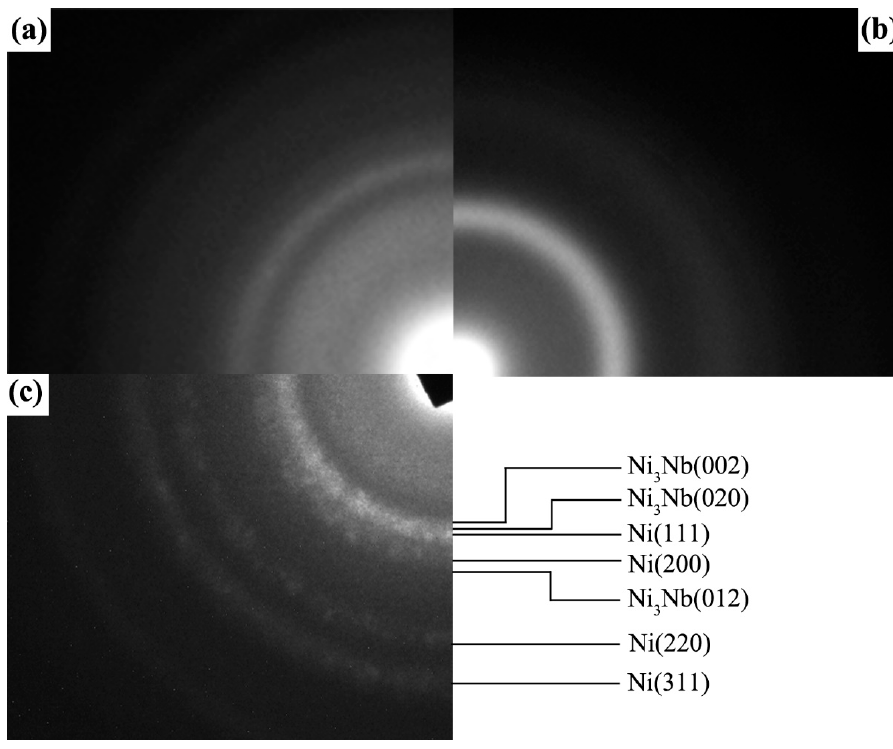
Figure 4. SAED patterns of local area for Ni-Nb coating with different number of pulses. ( a ) 10 pulses; ( b ) 20 pulses; ( c ) 30 pulses. ( b ) 20 pulses; ( c ) 30